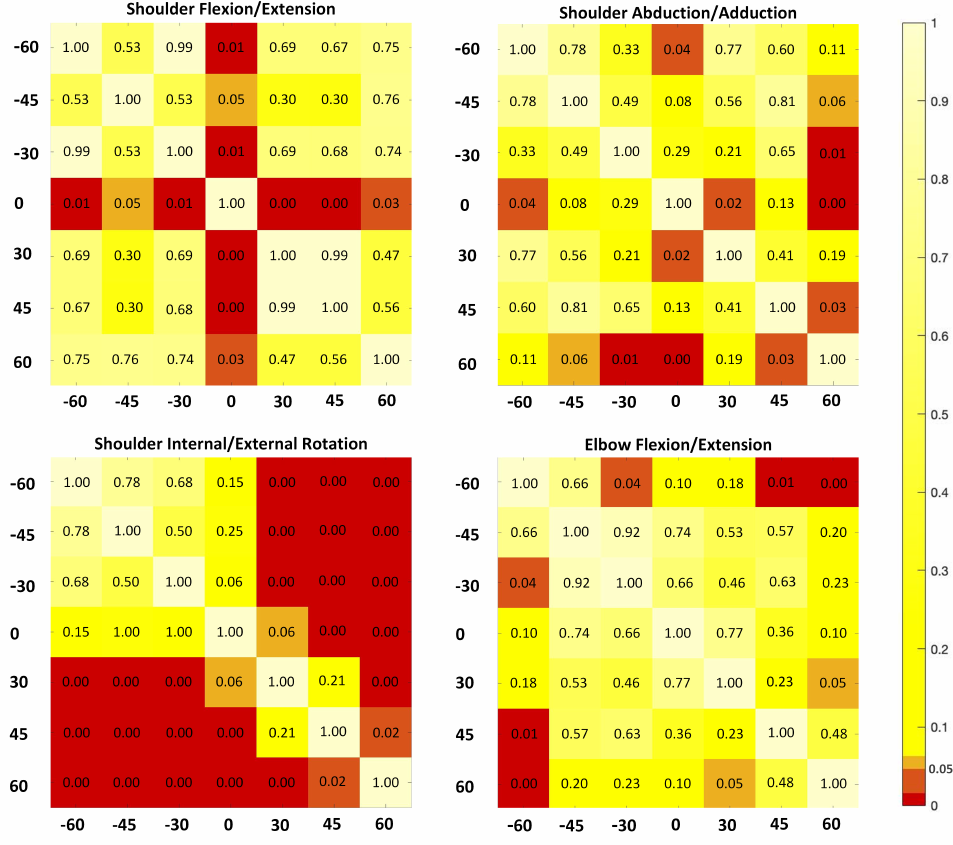
Figure 4. Post hoc statistical analysis on mean absolute errors (MAEs) of upper limb kinematics derived from a single Kinect-based system when the sensors are placed at seven orientations. The significant levels of MEAs between any two orientations are visualized. The colors from orange to red mean that the significant levels are lower than